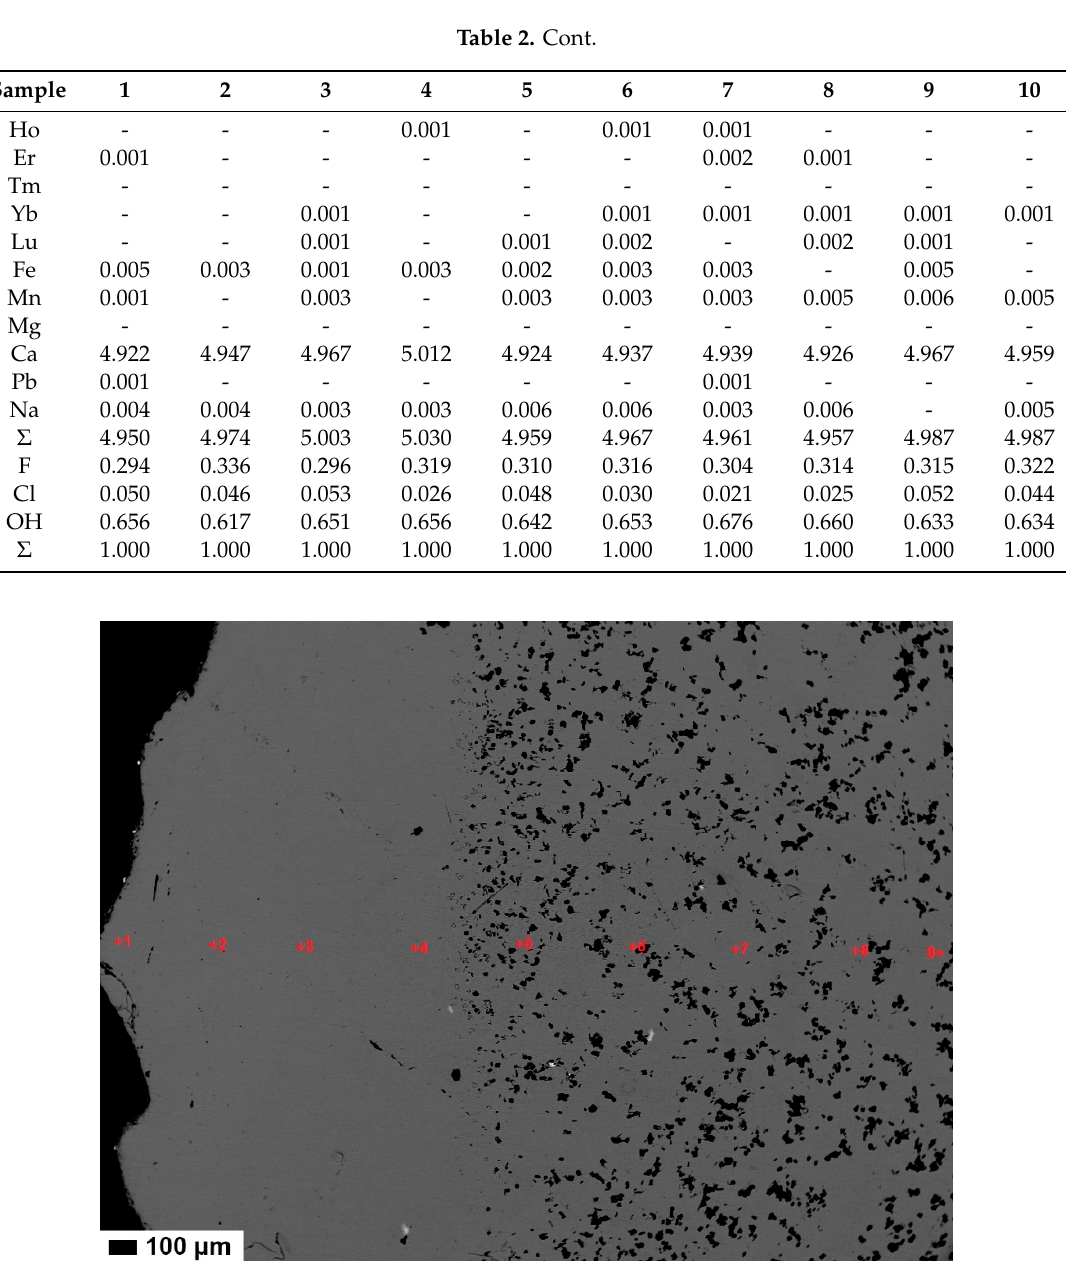
Figure 5. Back-scattered electron image of hydroxylapatite from Muránska Dlhá Lúka with marks and numbers of measured points. Table 3. The trace-elements contents (in ppm) in hydroxylapatite from Muránska Dlhá Lúka measured by laser-ablation inductively coupled plasma mass spectrometry (LA–ICP–MS; DL—limit of detection, <DL—content below the detection limit of respective element).